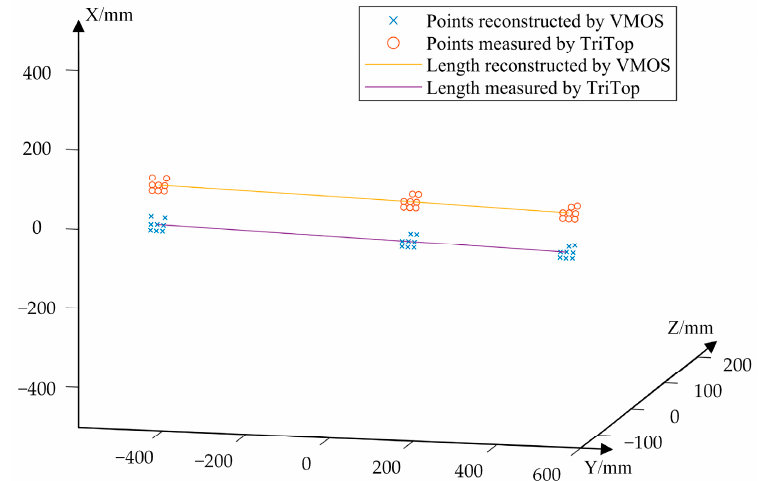
( b ) Figure 13. Scene of the scale bar reconstruction experiment. ( a ) The experiment scene. ( b ) Close-up of the scale bar. Following the method in Section 2.3, the coordinates of the 24 points on the three coded markers on the scale bar were reconstructed with the calibrated VMOS, as shown in Figure 14. To evaluate the reconstruction accuracy, the coordinates of the three sets of coded points were measured using TriTop ® from GOM CO. in Brunswick, Germany as well and regarded as the ground truth. Then, the distances between each dot of the No. 0